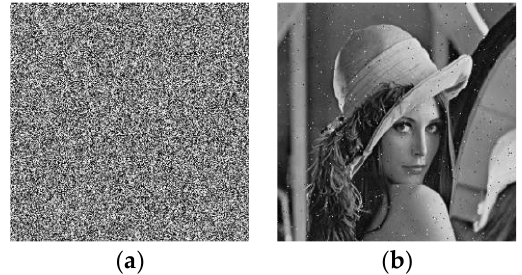
Figure 11. Salt and pepper noise intensity of 1%: ( a ) encrypted image and ( b ) decrypted image.